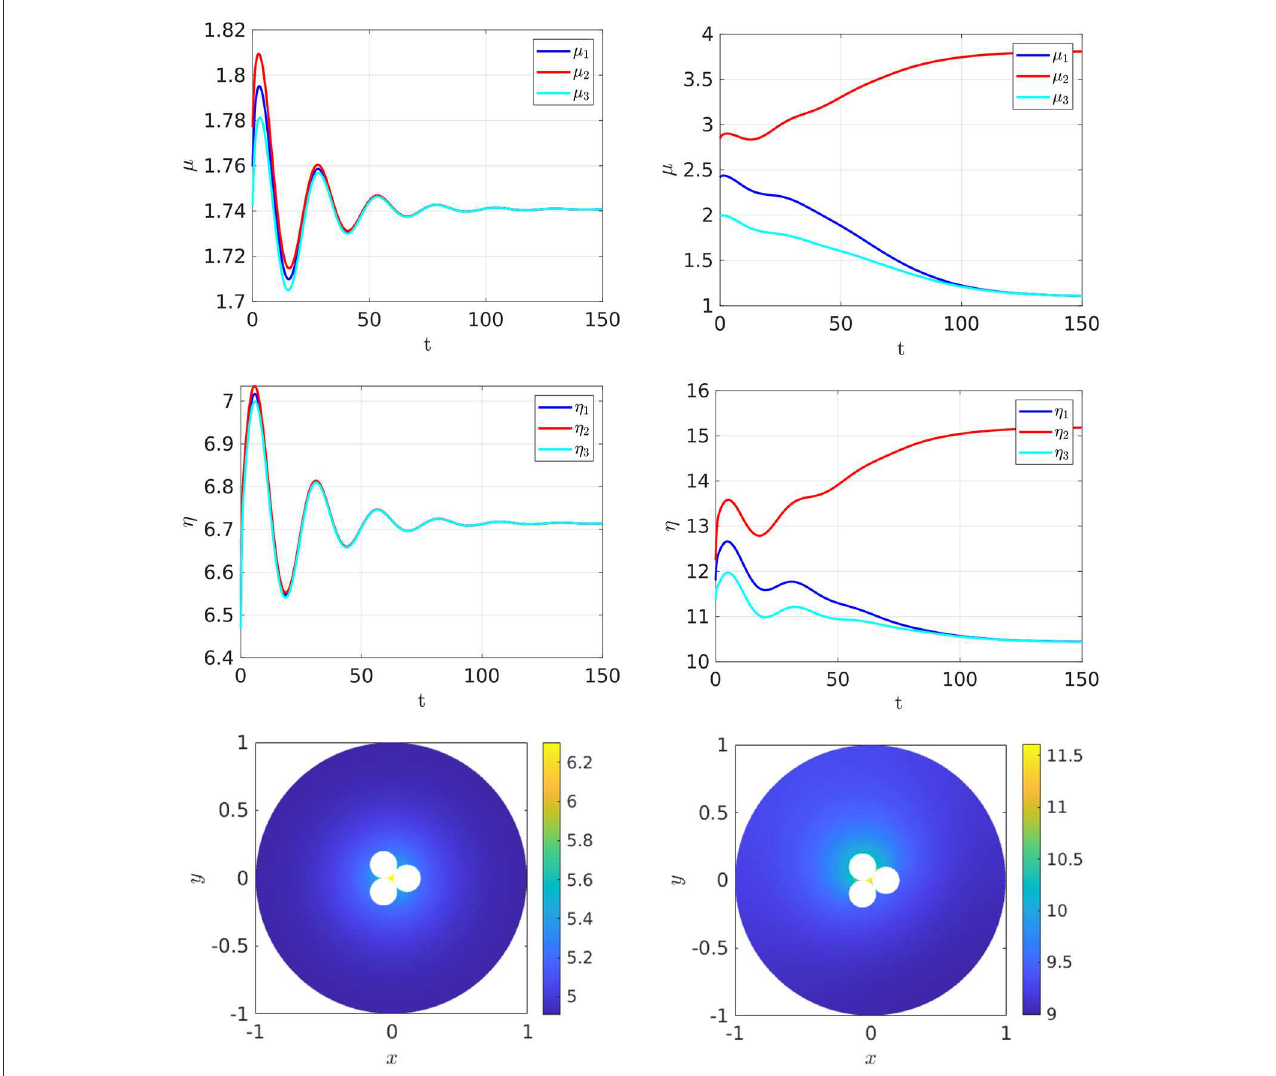
FIGURE18 Full numerical simulation results of Equation (2.3) with FlexPDE [50] for GM kinetics (Equation 4.3) with three closely spaced cells with cell centers located on the vertices of an equilateral triangle centered at the origin. The ring radius is r Right: convergence to an asymmetric steady-state when ρ separation of 0.002. The bottom two panels show the concentration of v . By plotting v rather than u , the bottom right panel clearly shows the asymmetry in the three